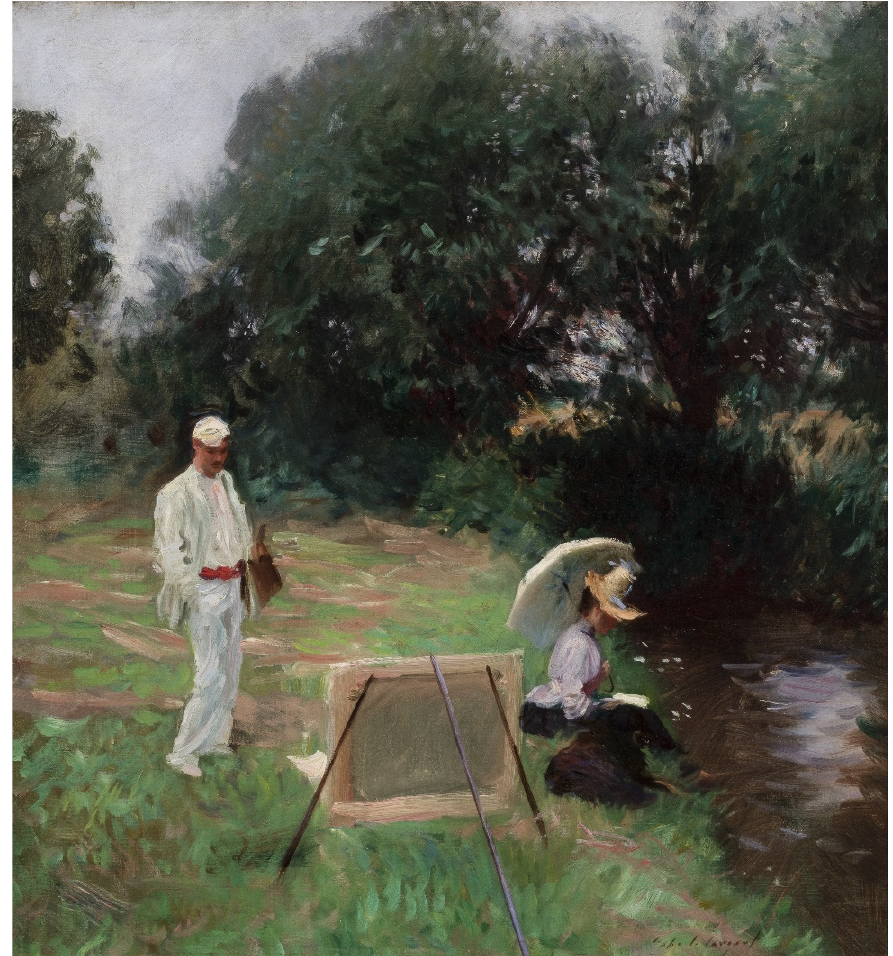
Figure 6. John Singer Sargent, Dennis Miller Bunker Painting at Calcot, 1888, Oil on canvas mounted on Masonite, 68.6 × 64.1 cm, Terra Foundation for American Art, Daniel J. Terra Collection, 1999.130. Bunker (1861–1890) was an American artist friend who spent the summer of 1888 with Sargent in Calcot Mill, a village west of London. In this painting, the painter is depicted from the front, in the middle distance, from a slightly elevated vantage point. Instead of looking at the surroundings, he appears absorbed in contemplation of its representation on canvas, standing with his hand, perhaps unconsciously, playing in his pocket.